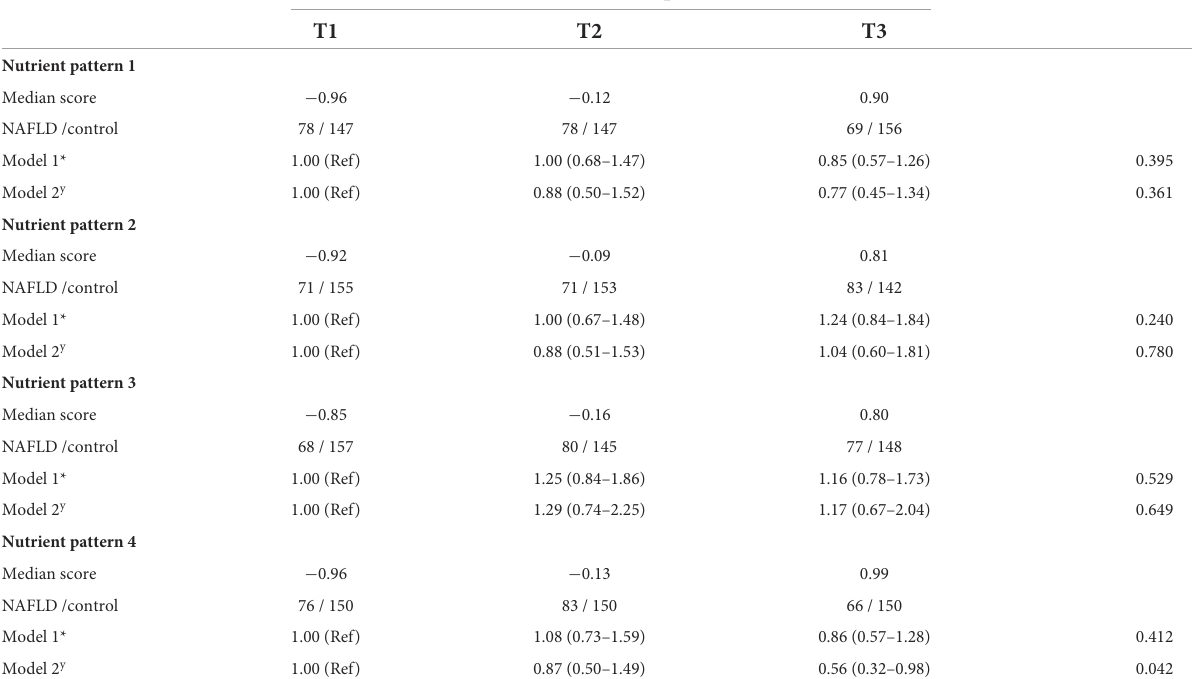
TABLE 4 Odds ratios (ORs) and 95% confidence intervals (CIs) for NAFLD based on tertiles of nutrient patterns. Tertiles of nutrient patterns P for